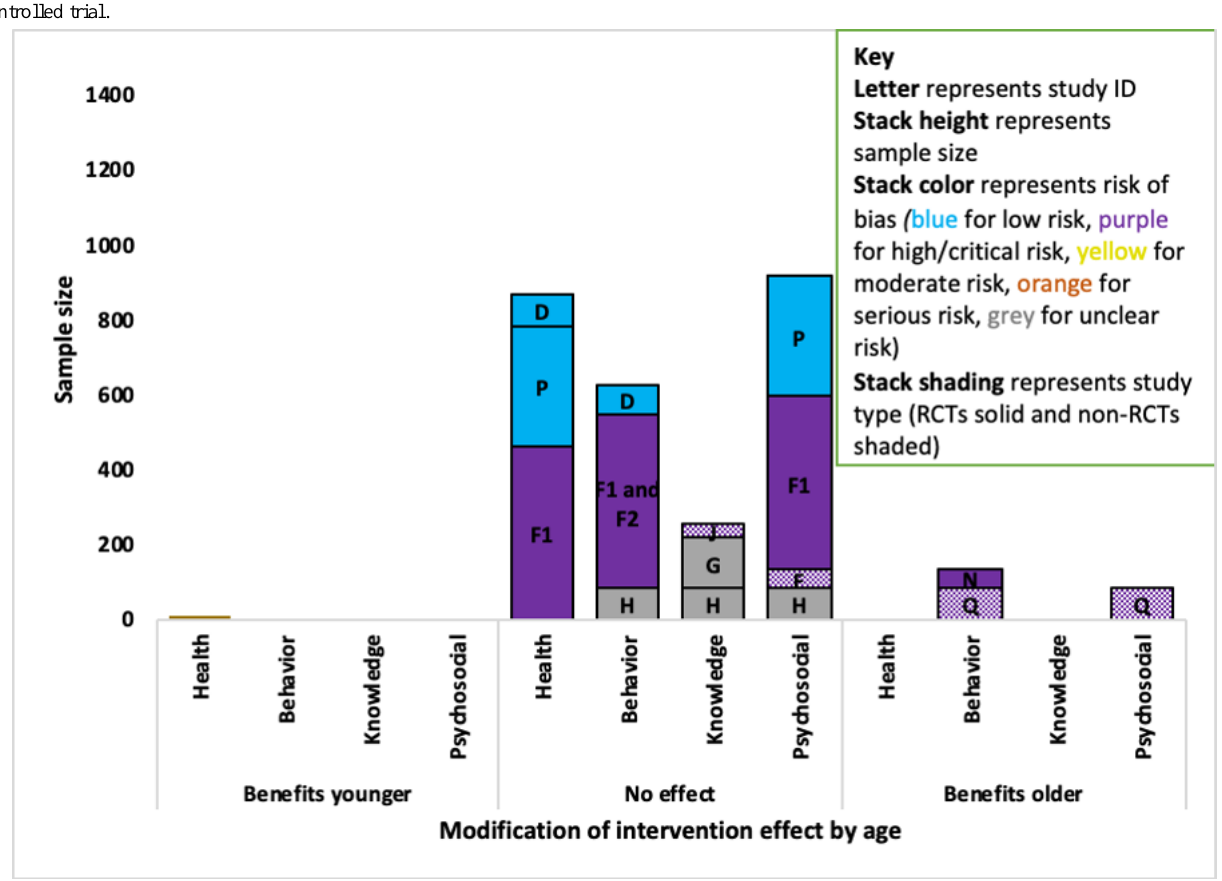
(ID D) indicated that female participants benefited more (Figure